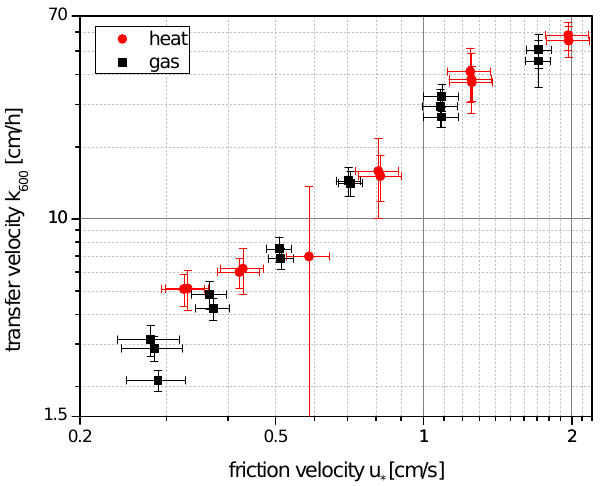
Figure 7. Simultaneously measured heat and gas transfer velocities, both scaled to a Schmidt number of Sc = 600 plotted against that of the friction velocity. The friction velocities for the local heat trans- fer measurements are 15% enhanced in comparison to the global values for the friciton velocities for the gas transfer velocity mea-